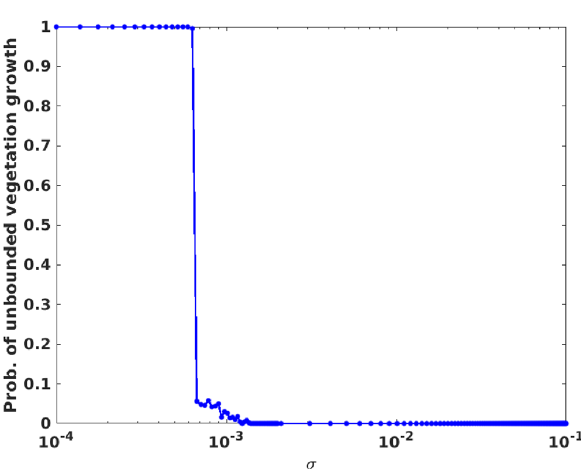
Figure 10. Probability of unbounded vegetation growth in presence of additive noise, with respect to noise strength σ . As in Fig. 1, a blow up to be considered to occur when the vegetation population exceeds 10 3 . Here the Allee parameter θ = 0.1 , and the other system parameters are the same as in Fig. 1. The probability is estimated from a sample of 10 3 initial states randomly distributed in a hyper-cube ( u ∈ [ 0 : 4 ] , v ∈ [ 0 : 2 ] , w ∈ [ 0 : 5 ] ) in phase